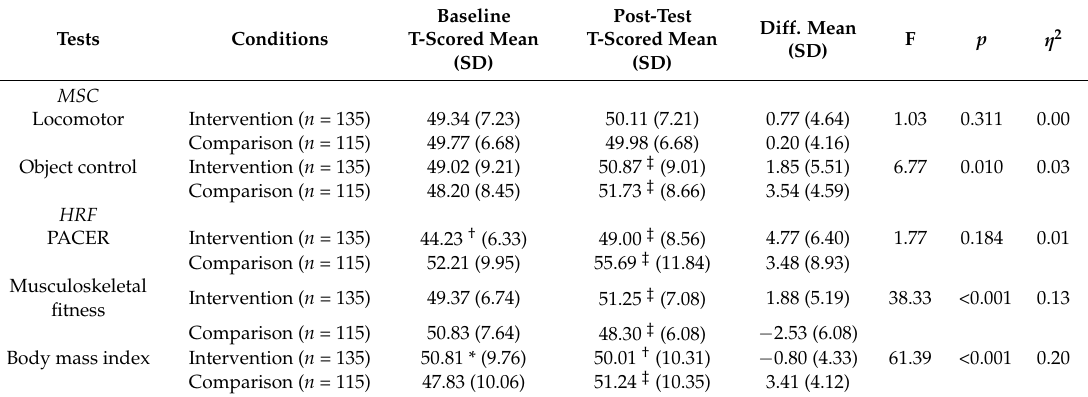
Table 2. Baseline and post-intervention motor skill competence and health-related fitness descriptive and inferential